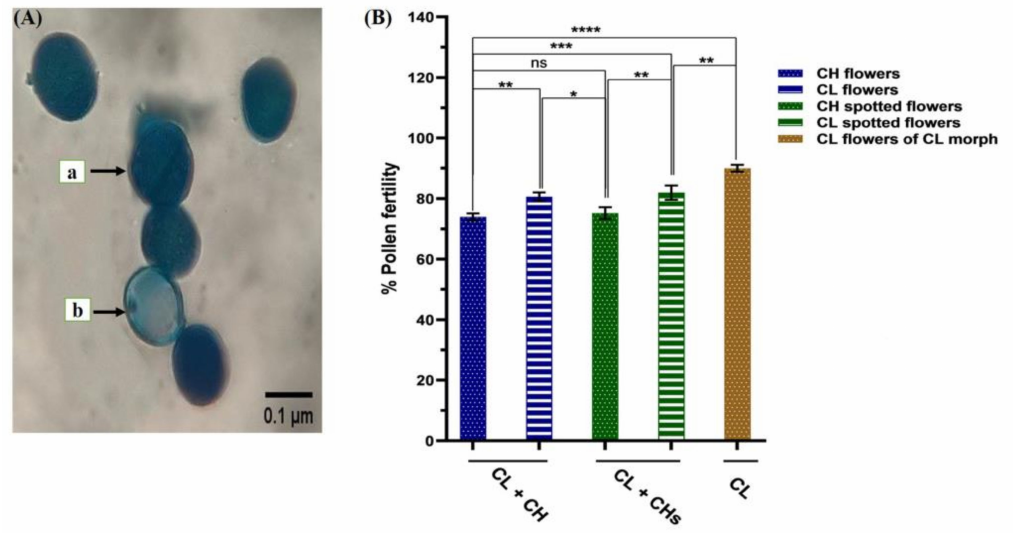
Figure 6. Pollen fertility in the three morphs ( A ) Pollen grains using Lactophenol cotton blue stain (a: Fertile pollen & b: Sterile pollen) ( B ) Percentages of pollen grain fertility in CL and CH flowers/morph. p values: * = 0.014, ** = 0.003, *** = 0.0003 and **** ≤ 0.0001 and ns: non-significant effect at